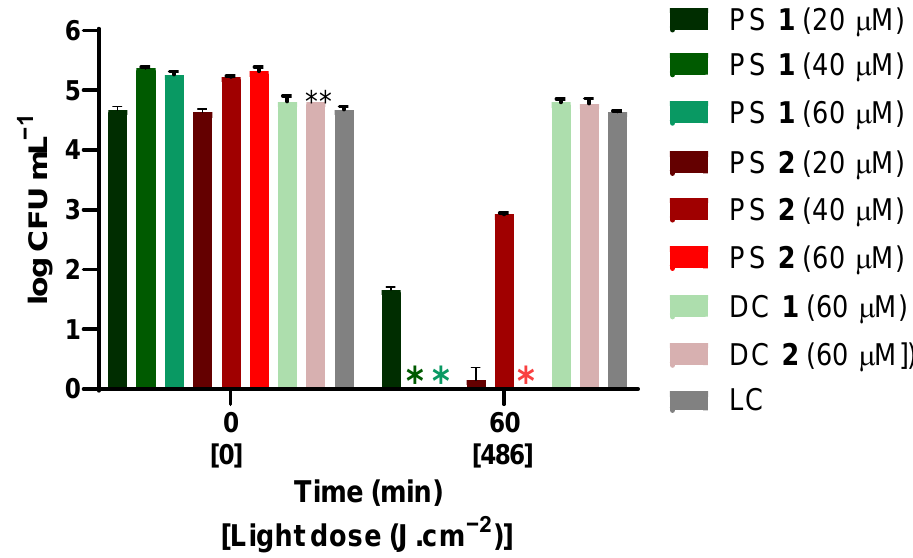
Figure 2. Variation in the concentration of viable conidia of F. oxysporum after 60 min irradiation with artificial white light at a fluence rate of 135 mW·cm −2 (486 J·cm −2 ) in the presence of 20, 40, and 60 µM of PS 1 or PS 2 . LC, light control; DC 1 , dark control with PS 1 at 60 µM; DC 2 , dark control with PS 2 at 60 µM. Values correspond to the average of three independent experiments with repli- cates. Error bars represent the standard deviation. *, no colonies observed; **, only one assay with three analytic replicates in which the number of colonies was exactly the same, producing a STD value of 0.